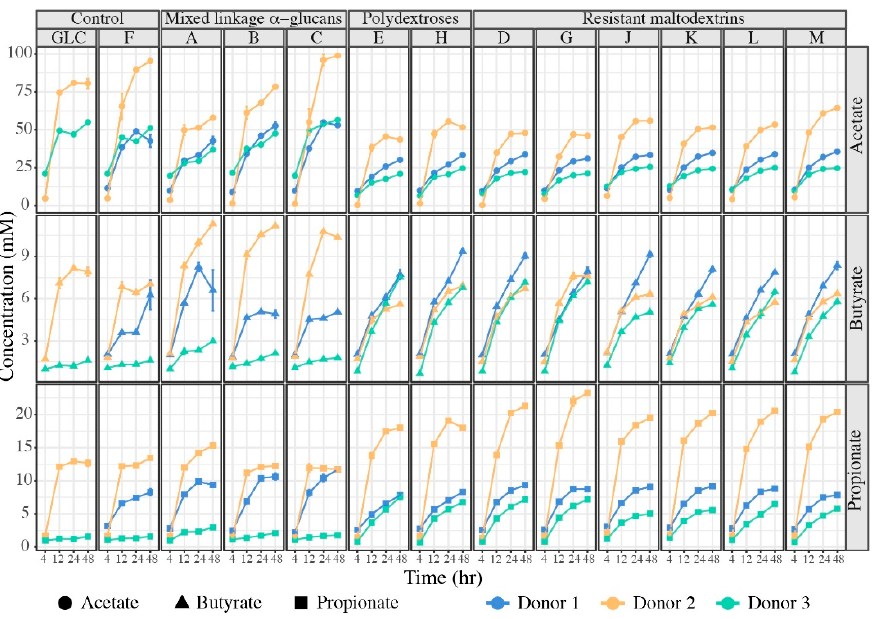
Figure 3. SCFA production at 4, 12, 24- and 48 h post-inoculation measured by gas chromatography. Different colors represent distinct responses of donors’ microbiota (blue: donor 1, orange: donor 2, green: donor 3) and different shapes represent the different SCFAs (acetate: circles, butyrate: triangles, propionate: squares). Individual glucans are represented by their letter designation; fructan (F) and glucose (GLC) were provided as controls. Error bars represent the standard deviation of the mean of three separate replicates.